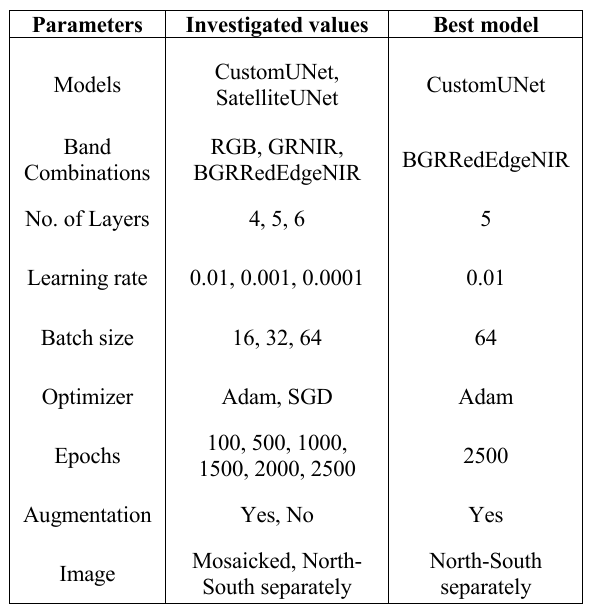
Table 2: Accuracy of proposed model